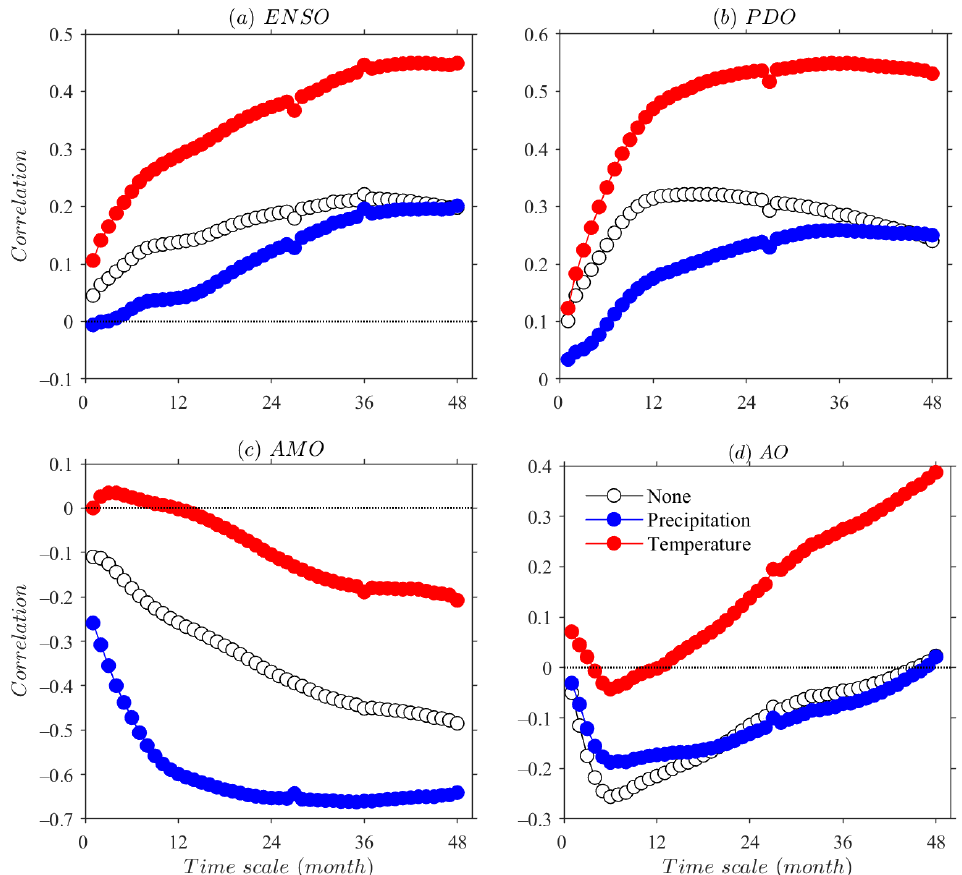
Figure 13. Correlation coefficients between Xinjiang SPEI and teleconnection indices ( a ) ENSO, ( b ) PDO, ( c ) AMO, and ( d ) AO on 1- to 48-month time windows during 1951–2020. White dotes denote correlation between teleconnections and SPEI without external control variable. Blue dotes denote correlation between the two without changing precipitation. Red dotes denote correlation between the two with unchanging